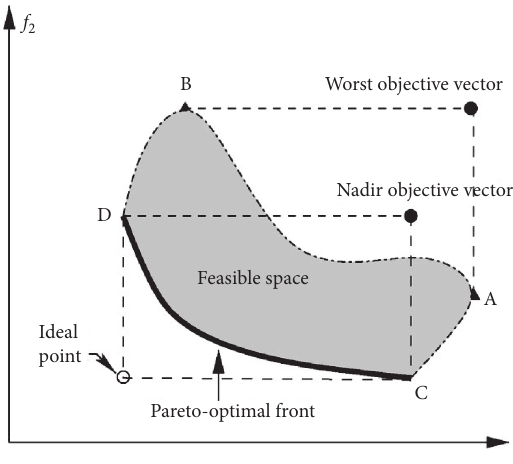
Figure 1: Ideal, nadir, and worst objective